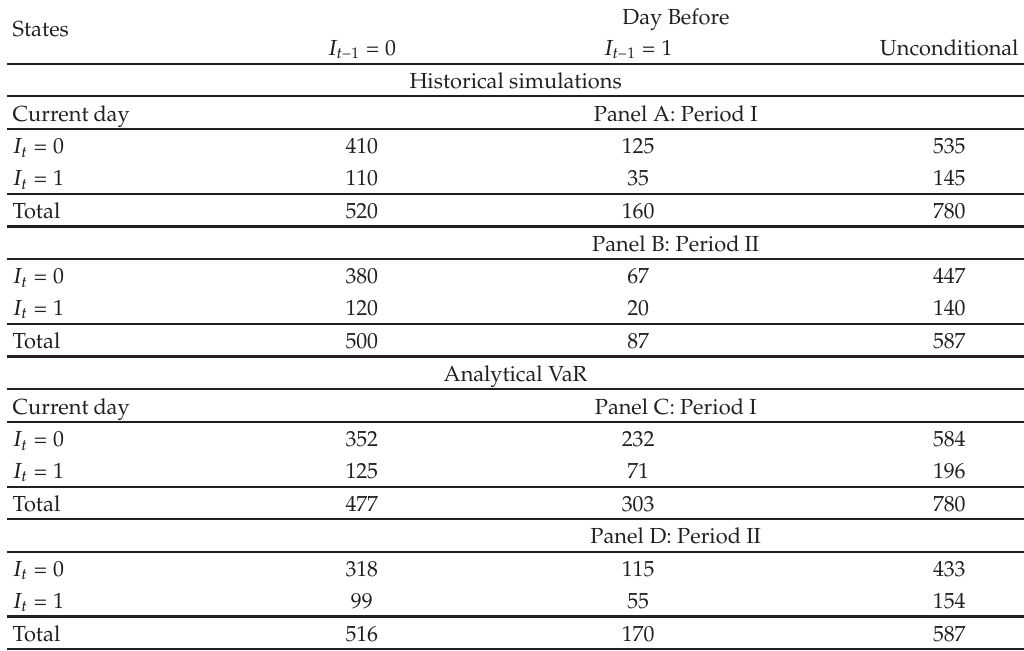
Table 6: Model accuracy using christo ff ersen’s independence test for a small